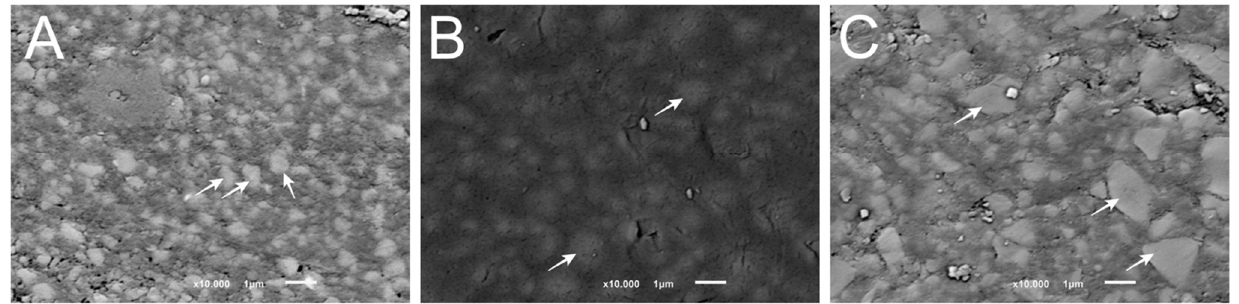
Figure 2. SEM images acquired by scanning electron microscopy (SEM) on different groups: ( A ) BE; ( B ) FS; and ( C ) AF, ORMOCER.